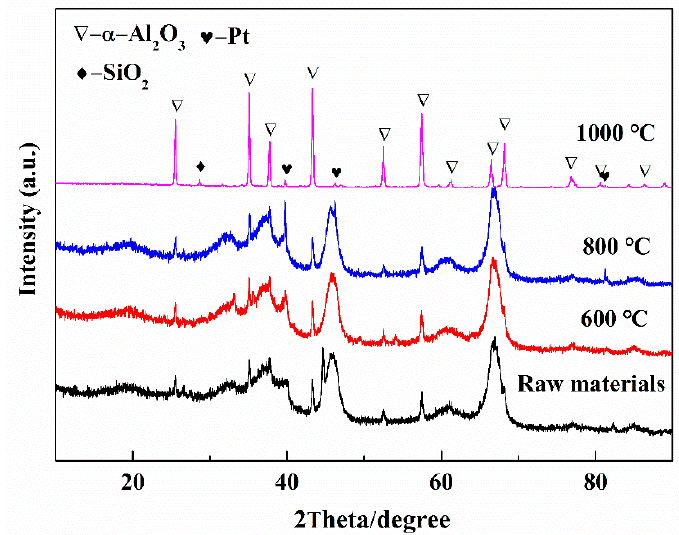
Figure 4. XRD patterns of spent petrochemical catalysts before and after calcination at 600 °C, 800 °C, and 1000 °C for 2 h in air atmosphere.